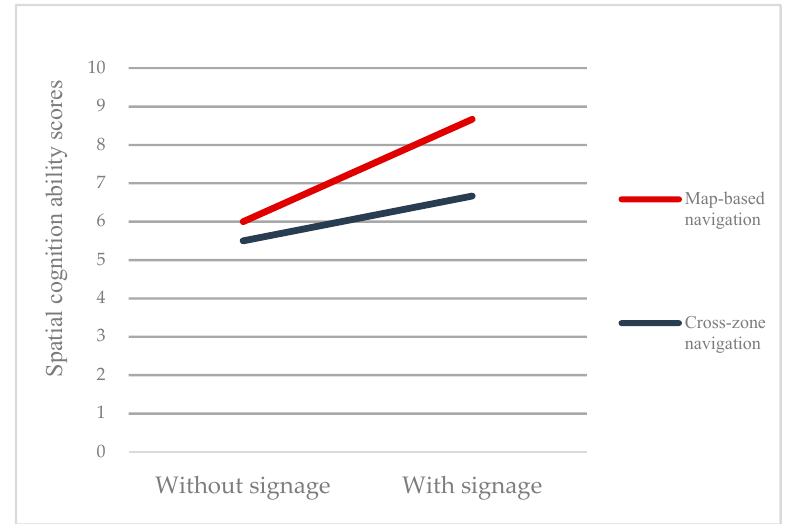
Figure 10. Interaction effect between navigation system and signage system on spatial perception ability.